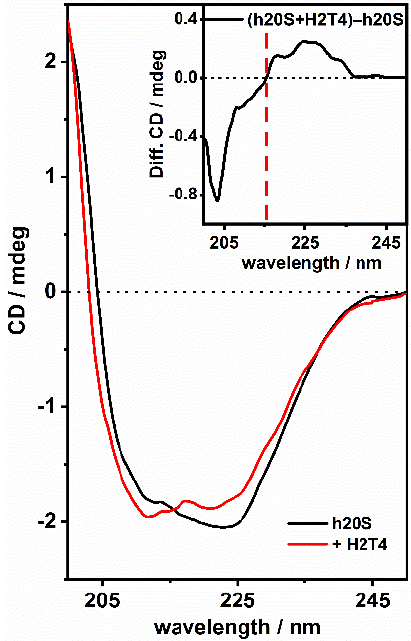
Figure 5. ECD spectra of 25 nM h20S proteasome in 150 mM Tris buffer with 100 mM of NaCl at pH 7.6, before (black trace) and after the addition of H2T4 1 µM (red trace). Inset: ECD difference between the spectra of h20S in the presence of H2T4 and that of